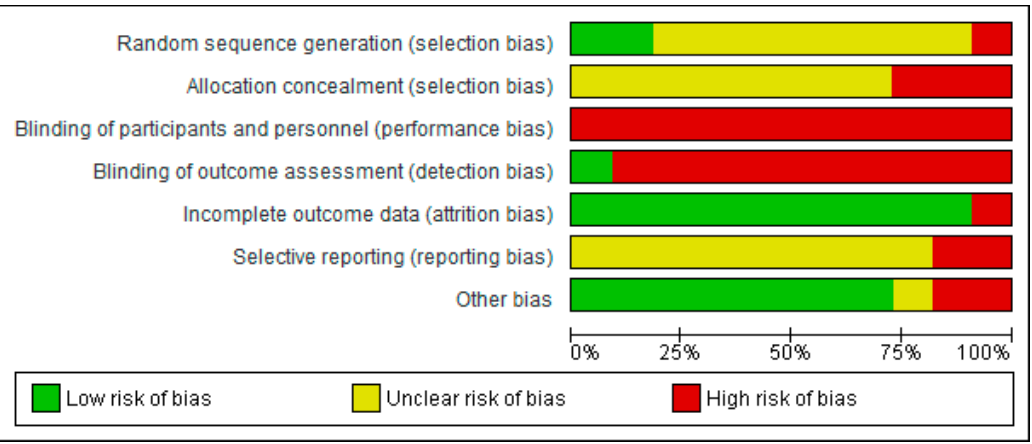
Figure 2. Risk of bias summary across randomized comparative trials: review authors’ judgements about each risk of bias item for each included study. Int. J. Environ. Res. Public Health 2019 , 16 , x